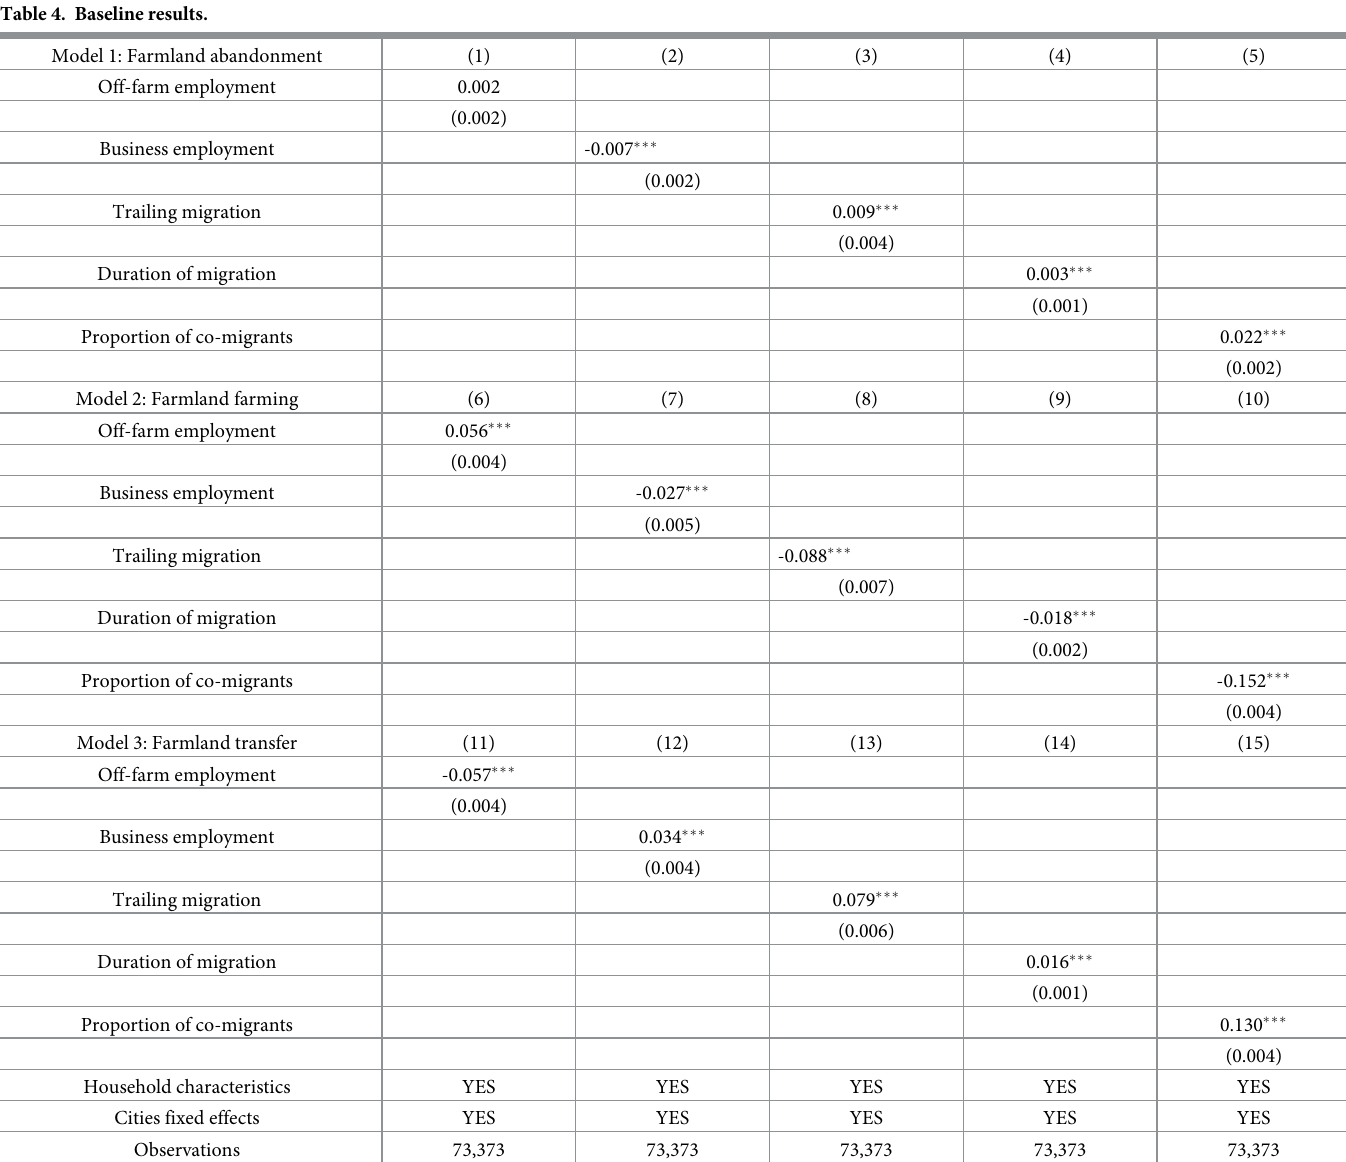
Table 4. Baseline